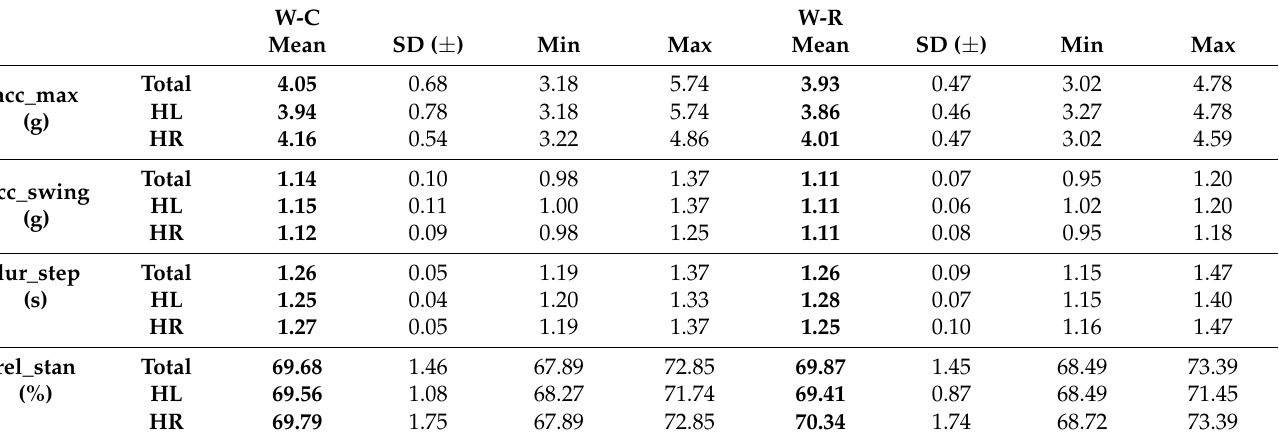
Table 4. Mean IMU data for ten dairy cows in total and differentiated between left (HL) and right hind limb (HR) during walk on concrete (W-C) and rubber mats (W-R).